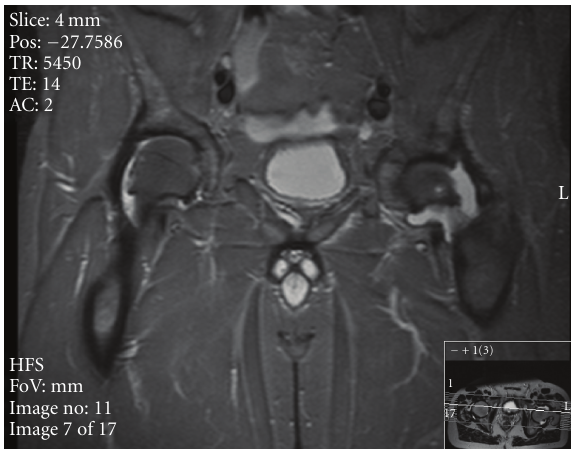
Figure 2: T2 weighted MRI scan of the